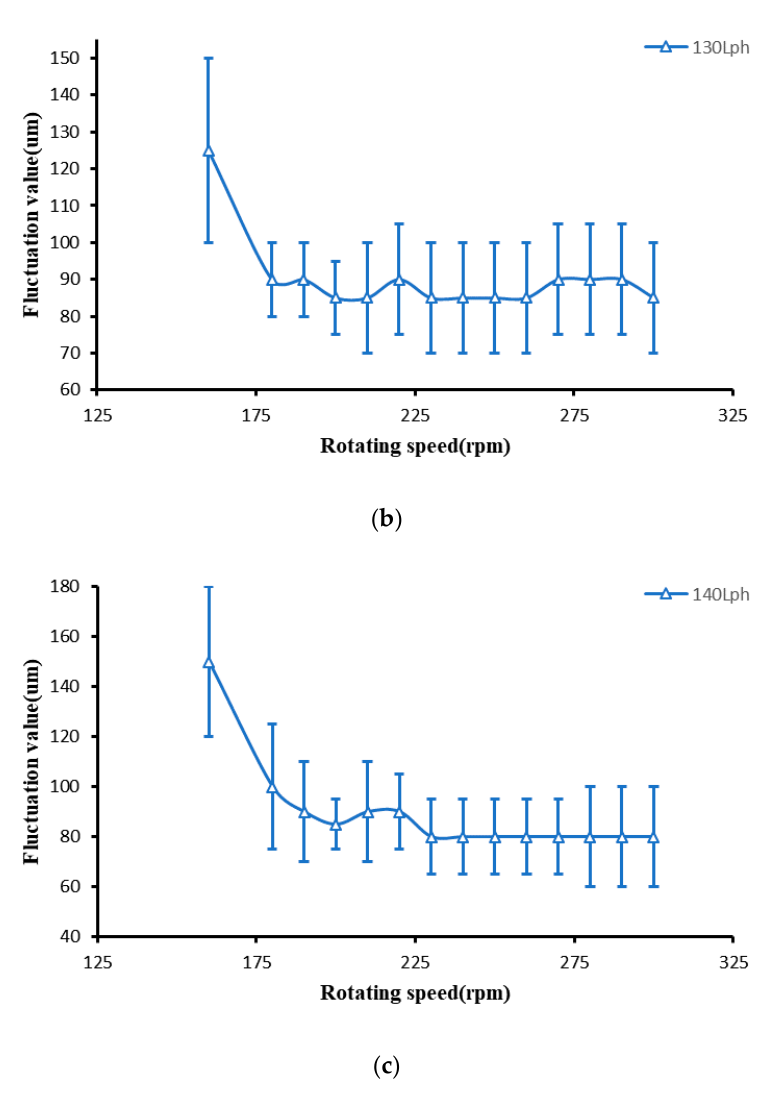
Figure 15. Variation in ribbon fluctuation with the rotating speed of the polishing wheel. ( a ) Flow rate 120 Lph. ( b ) Flow rate 130 Lph. ( c ) Flow rate 140 Lph.